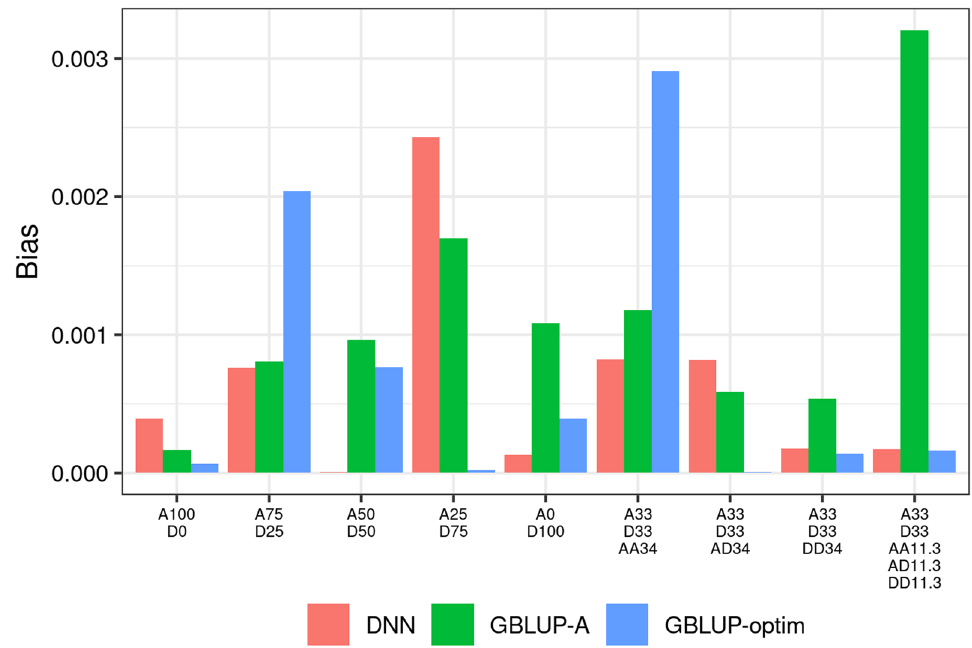
Figure 6. Bias of predictions for the different models across the range of simulated phenotypes (from purely additive, to purely dominant, to different flavors of epistasis). DL deep learning, GBLUP-A GBLUP with the additive relationship matrix only, GBLUP-optim GBLUP with multiple relationship matrices corresponding to the nature of the